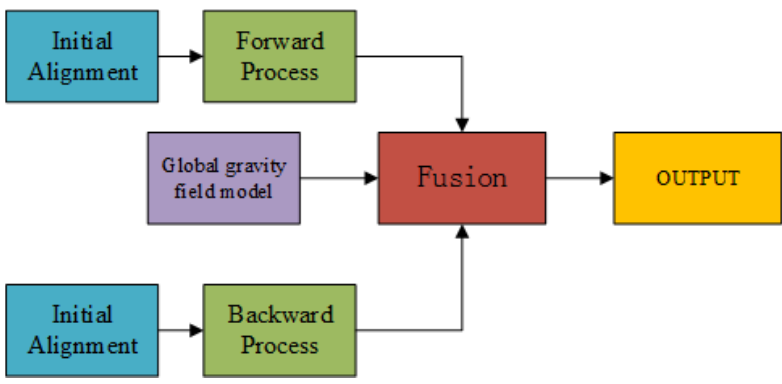
Figure 8. Scheme of forward backward